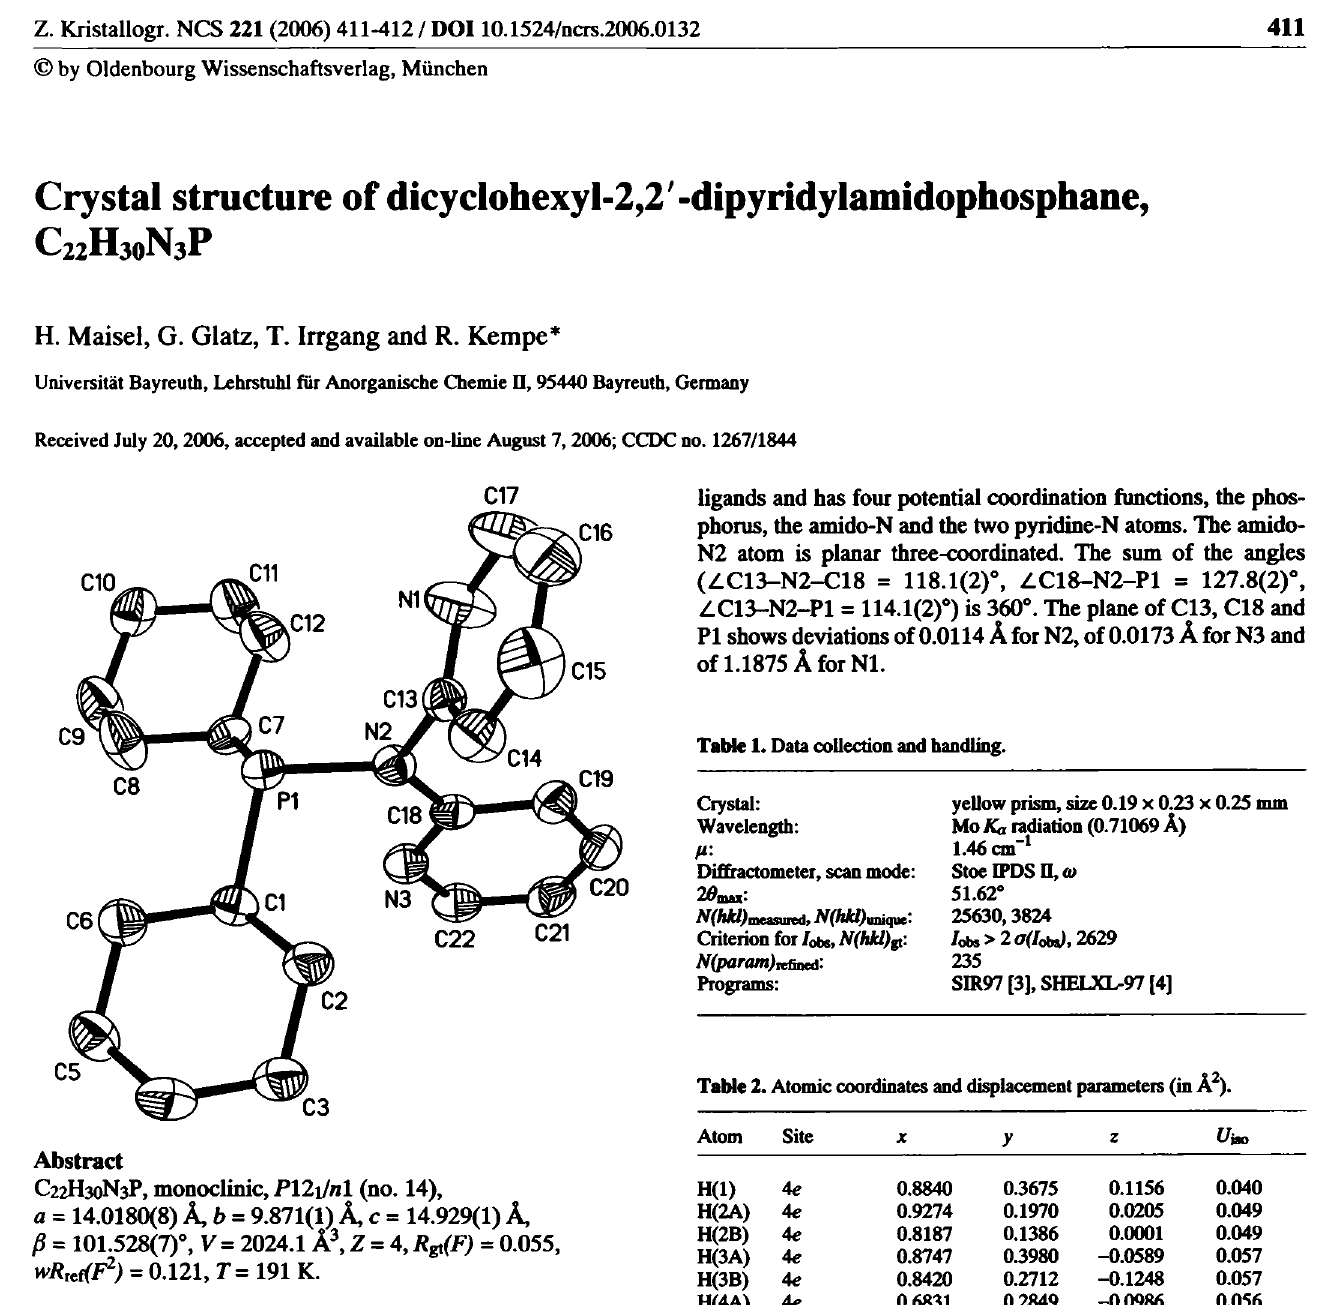
Table 2. Atomic coordinates and displacement parameters (in A 2